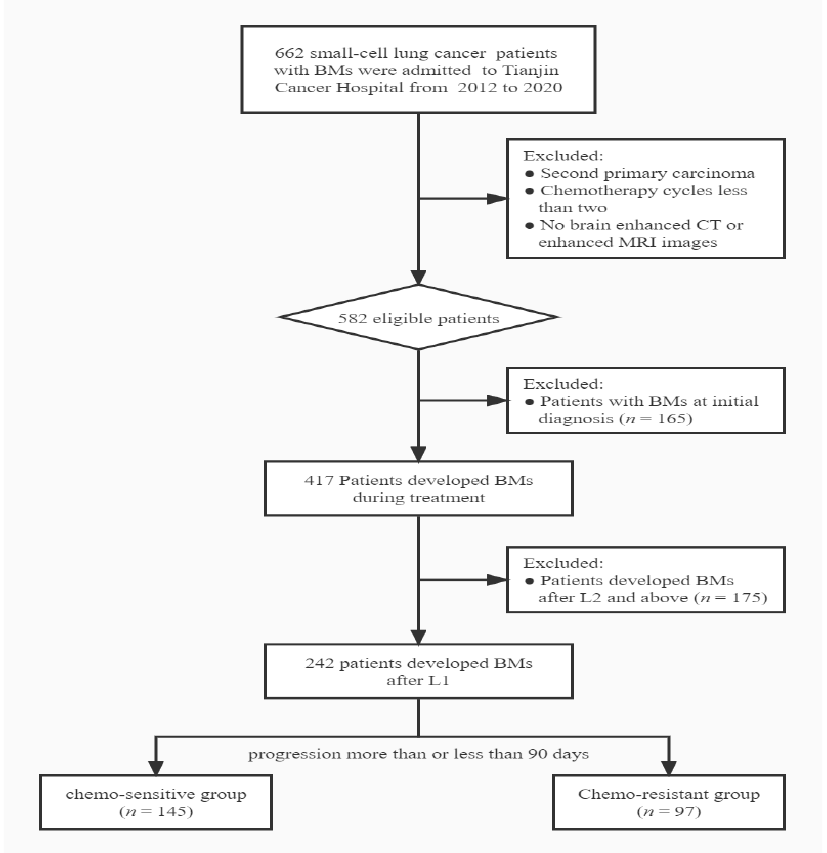
Figure 1. Patients’ selection diagram. BM: brain metastasis; L1: first-line chemotherapy; L2: second- line chemotherapy.